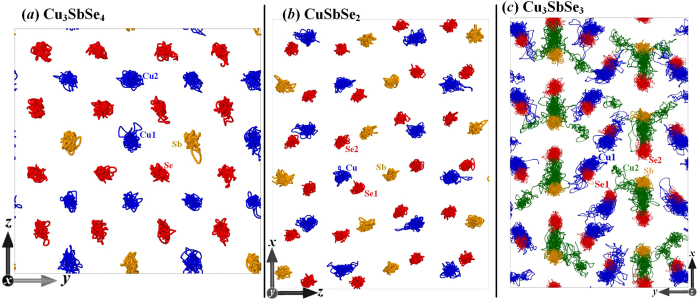
Trajectories of atoms from molecular dynamics simulations for (a) Cu3SbSe4, (b) CuSbSe2, and (c) Cu3SbSe3 at 400 K.